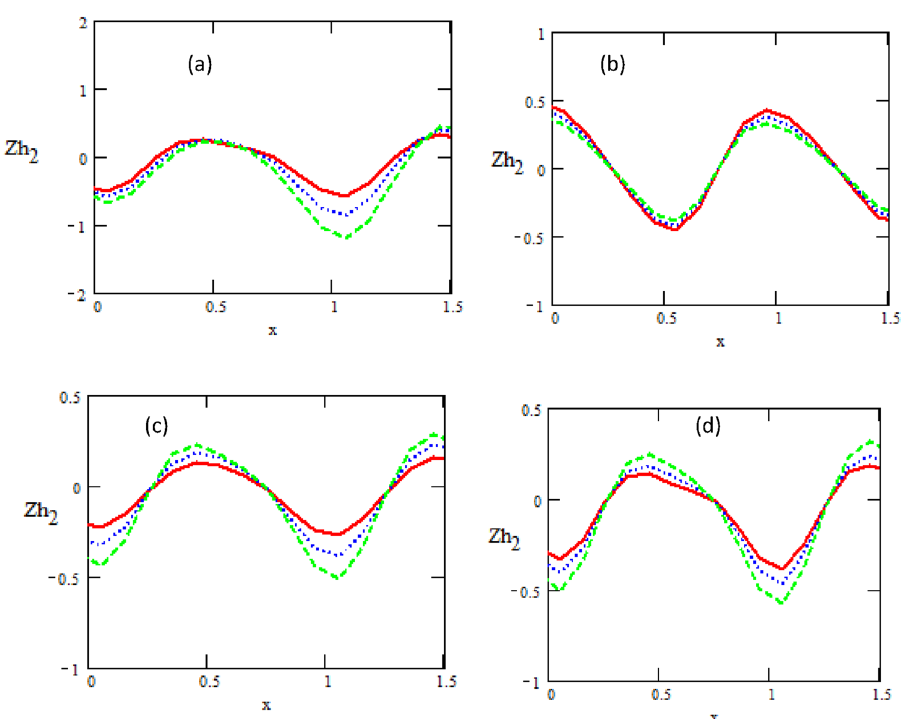
0.01_, 0.05. .., 0.09 , ( b ) K 1 = − − . − −